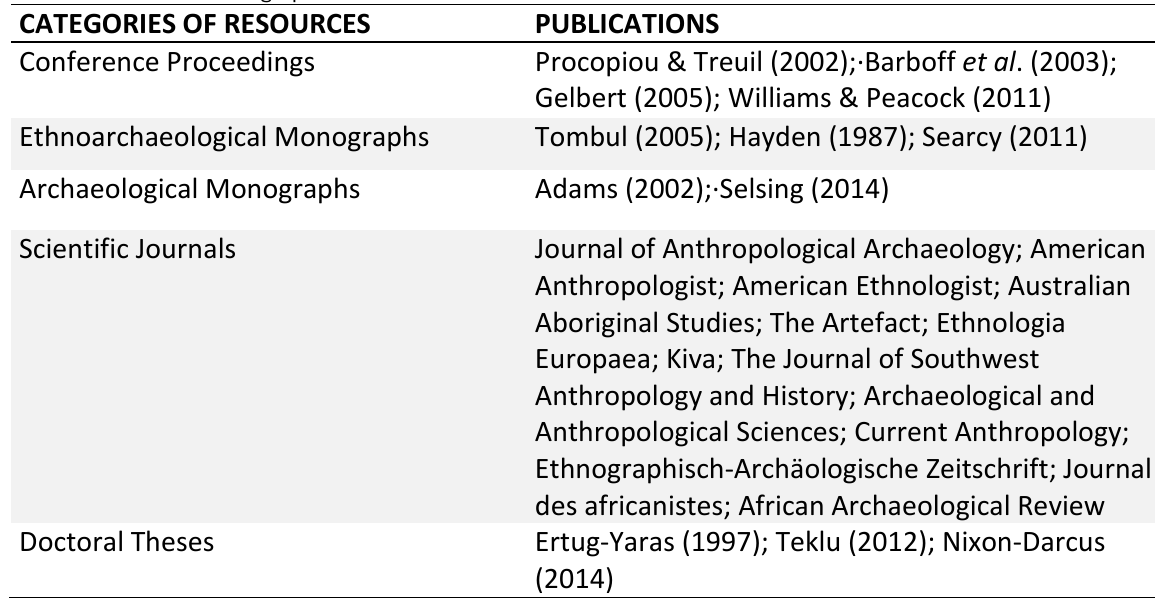
Table 1. The main bibliographic resources consulted about handmills and their